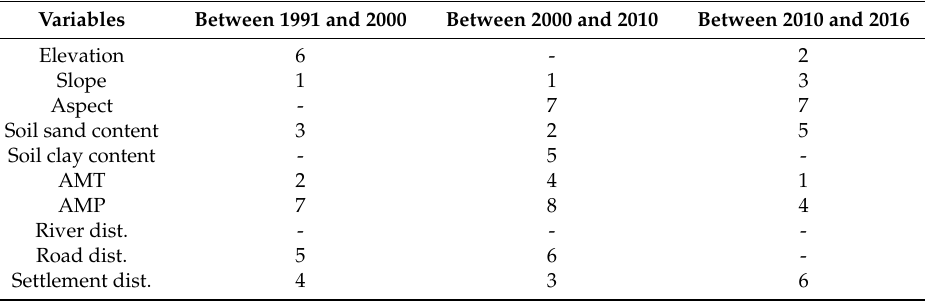
Table 7. Farmland contraction drivers in order of importance for the three LR models. Variables Between 1991 and 2000 Between 2000 and 2010 Between 2010 and 2016